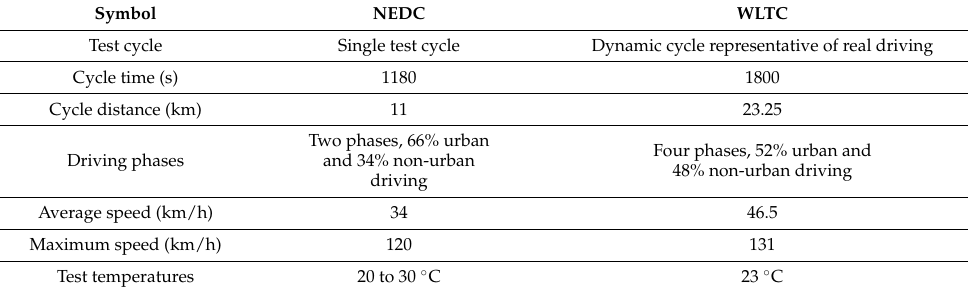
Figure 6. WLTP/WLTC test cycle including low, medium, high and extra-high phases. Table 3. Comparison of driving cycles.